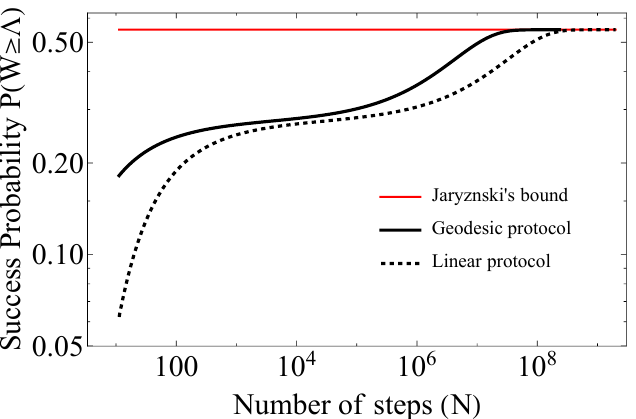
= 6, E = 0.1, Λ = − 2 ∆ F , i f